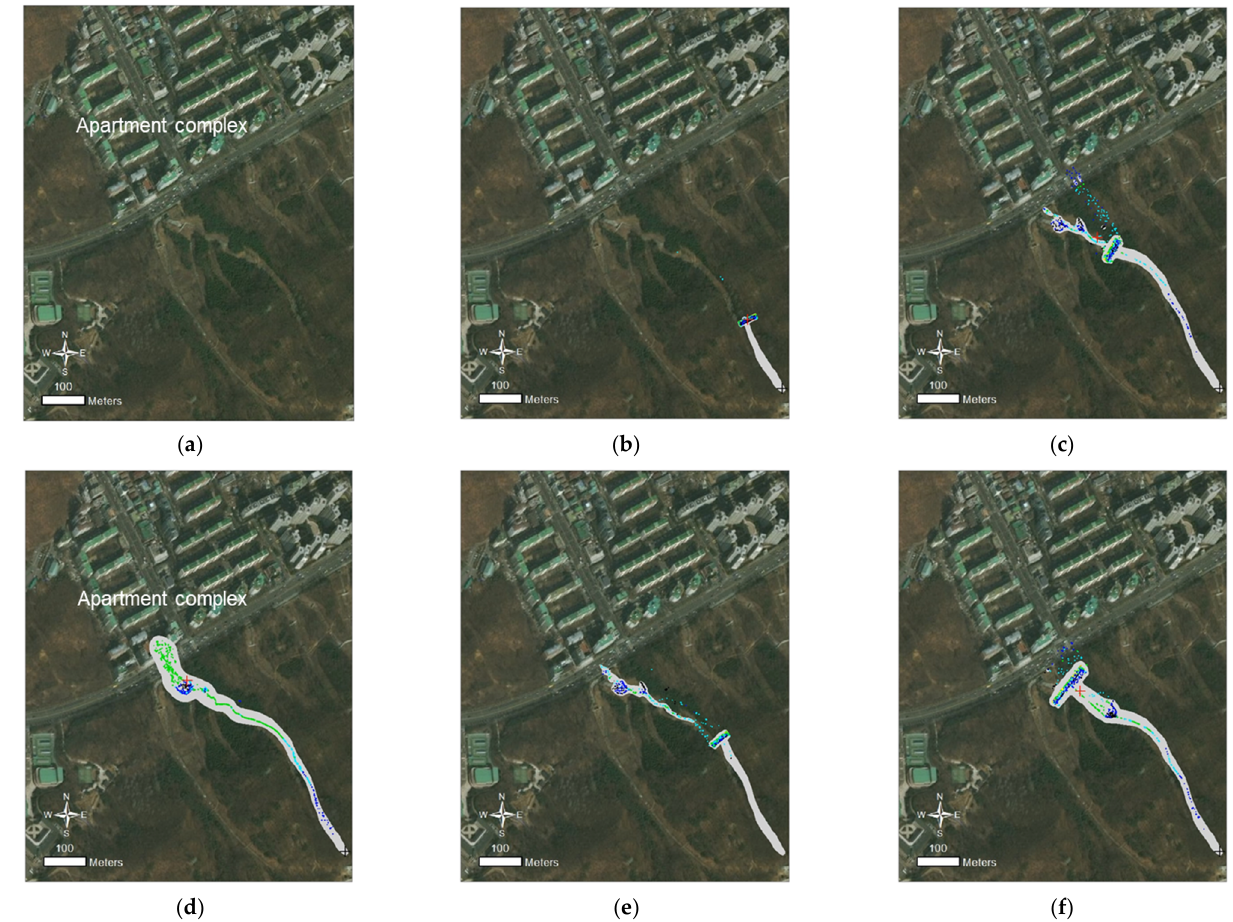
Figure 3. Snapshots at the end points of the debris flow simulations: ( a ) before the event; ( b ) Case REF; ( c ) Case 0.3 L; ( d ) Case 0.5 L; ( e ) Case 0.7 L; ( f ) Case 0.9